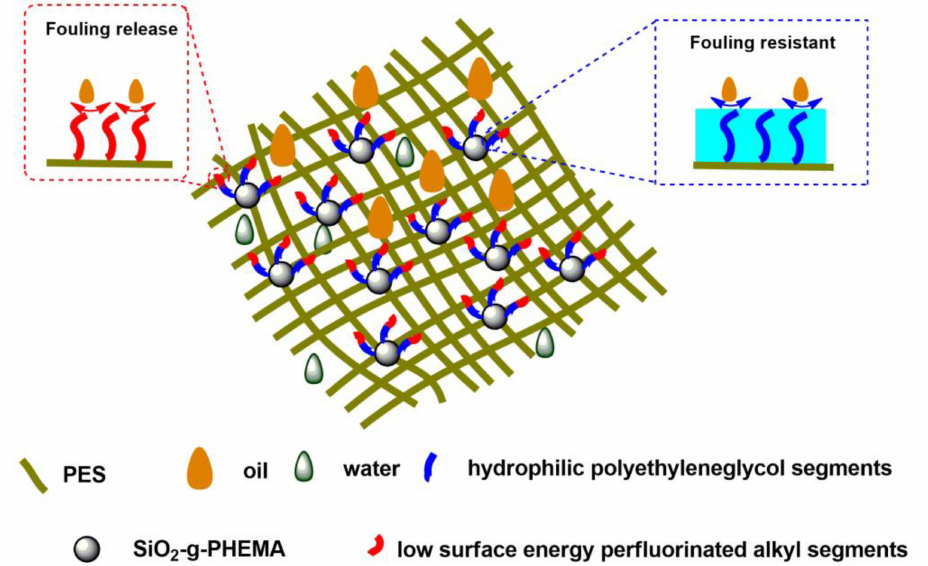
Figure 9. A tentative illustration of the anti-fouling and self-cleaning mechanism of the PES/SiH1/fP